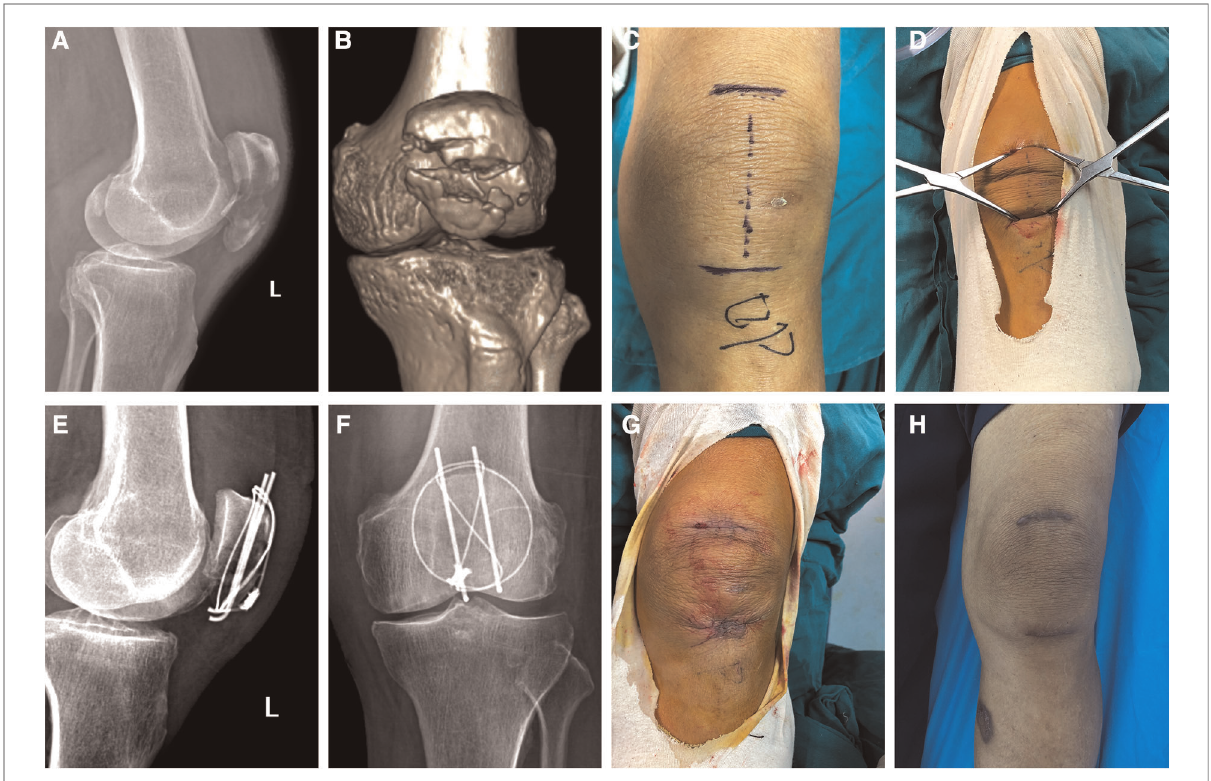
FIGURE 3 Radiographs and photographs of the knee of a 73-year-old male patient who suffered patellar fracture and received surgical treatment via the minimally invasive technique. ( A ) Lateral view of a preoperative radiograph of the knee joint. ( B ) 3D reconstruction image of patellar computer tomography scanning. ( C ) Photograph of an incision mark. ( D ) Two-pointed bone reduction forceps were applied to reduce the fracture displacement. ( E ) Lateral view of a postoperative radiograph of the knee joint reveals good bone reduction. ( F ) Anteroposterior view of